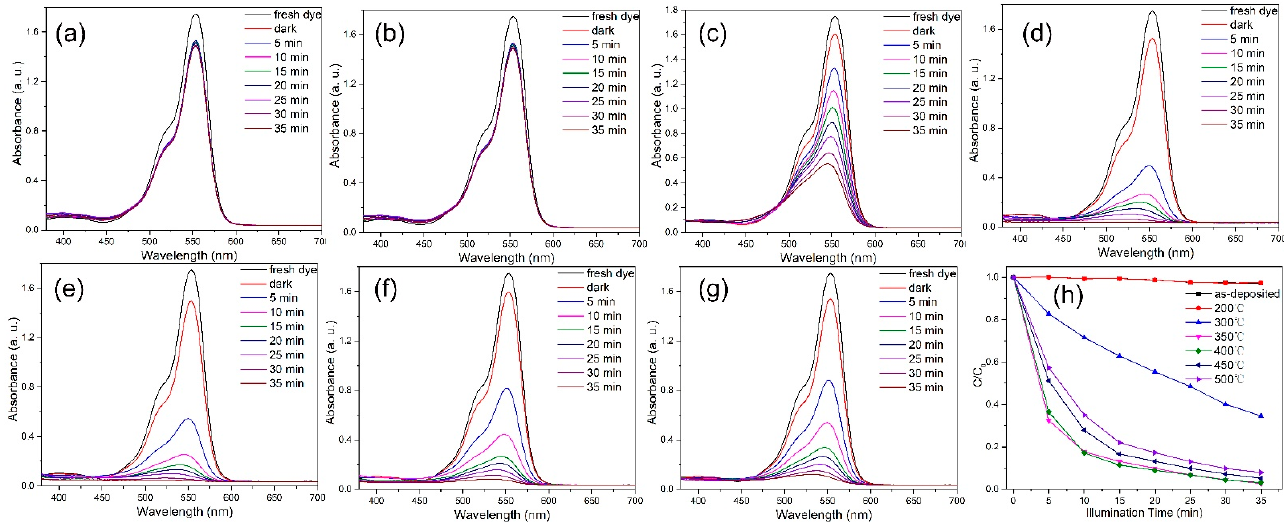
Figure 7. UV-vis absorbance spectra of RhB solutions treated with the ZnO micro-sphere catalysts prepared at ( a ) RT and annealed at ( b ) 200, ( c ) 300, ( d ) 350, (e) 400, ( f ) 450, and ( g ) 500 °C. The samples were illuminated for different periods. ( h ) Photodegradation of RhB catalyzed by the hierarchical ZnO micro-spheres annealed at different temperatures.